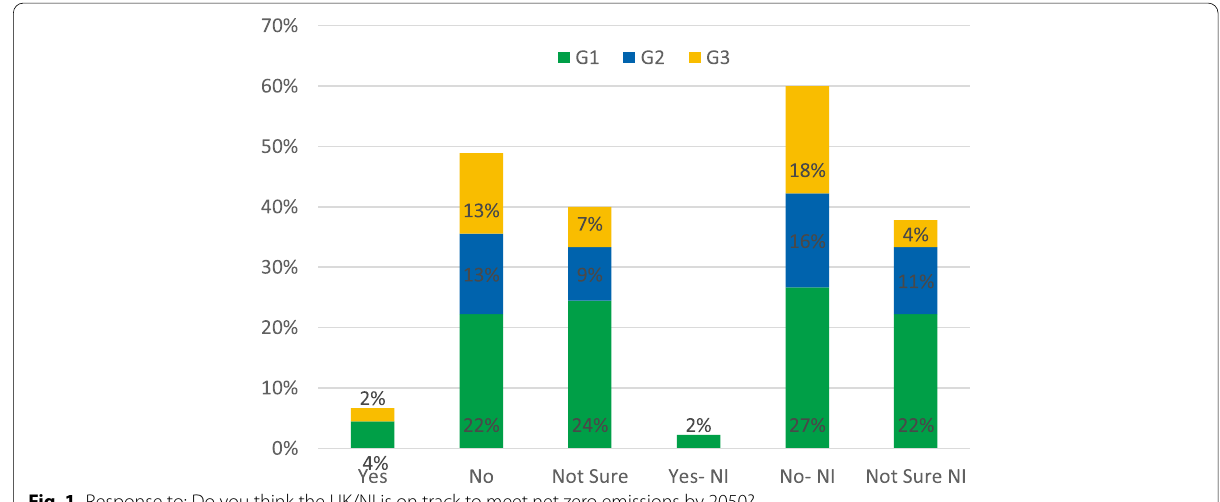
Fig. 1 Response to: Do you think the UK/NI is on track to meet net zero emissions by